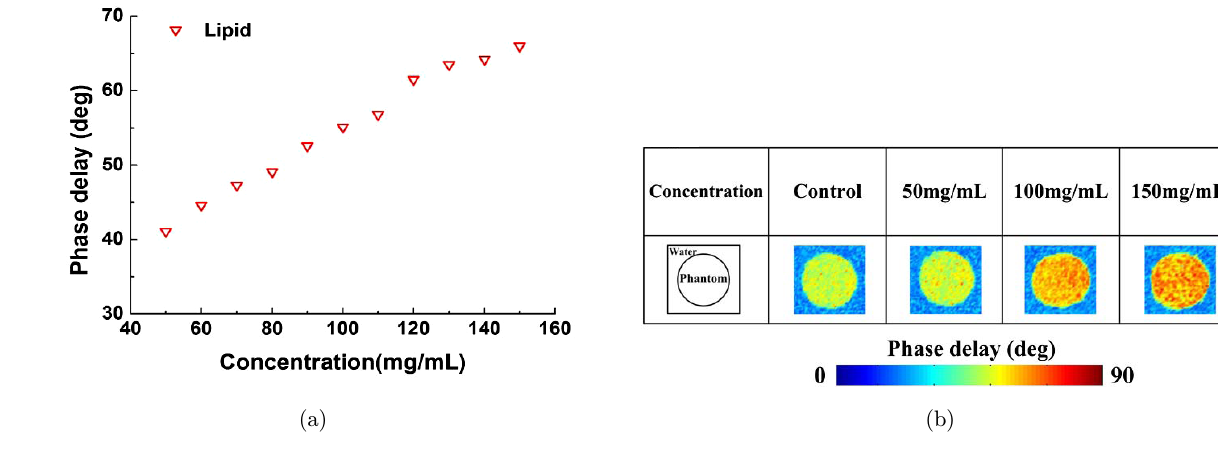
Fig. 6. (a) Relation between the lipid concentration and phase delay. (b) PAVE imaging of phantoms containing various concentrations of